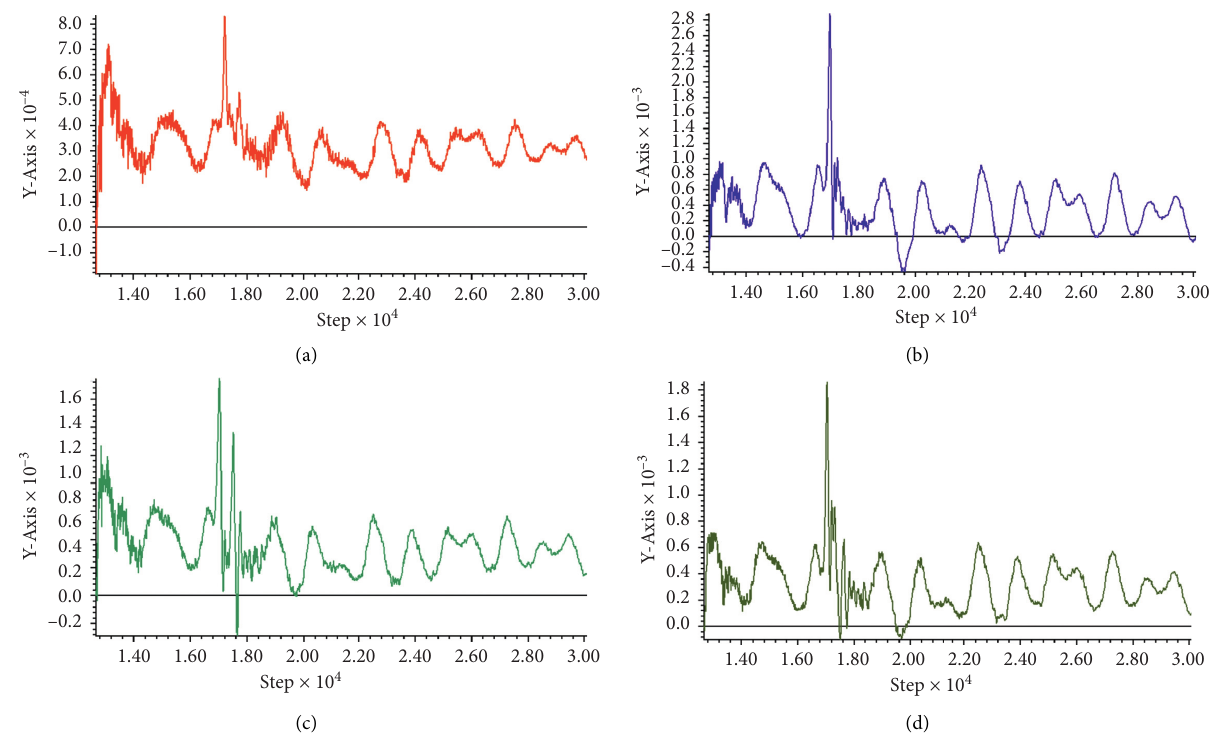
Figure 6: Displacement of ahead roadway versus time of right side: (a) fully mechanized excavation and (b) blast excavation.